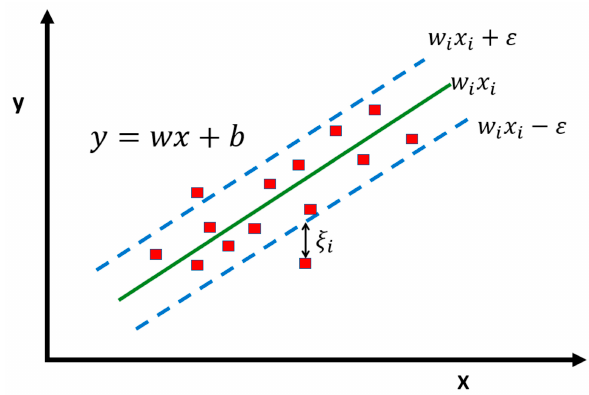
Figure 6. Linear